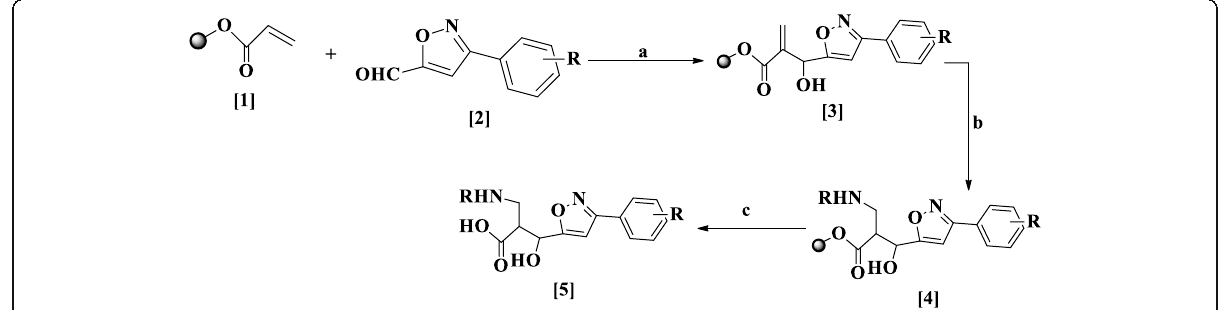
Scheme 1 Synthesis of 3-substituted phenyl-5-isoxazolecarboxaldehydes by Michael